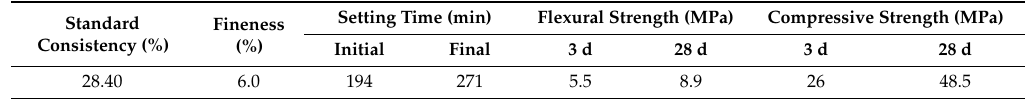
Table 2. Quality index of fly ash (%).